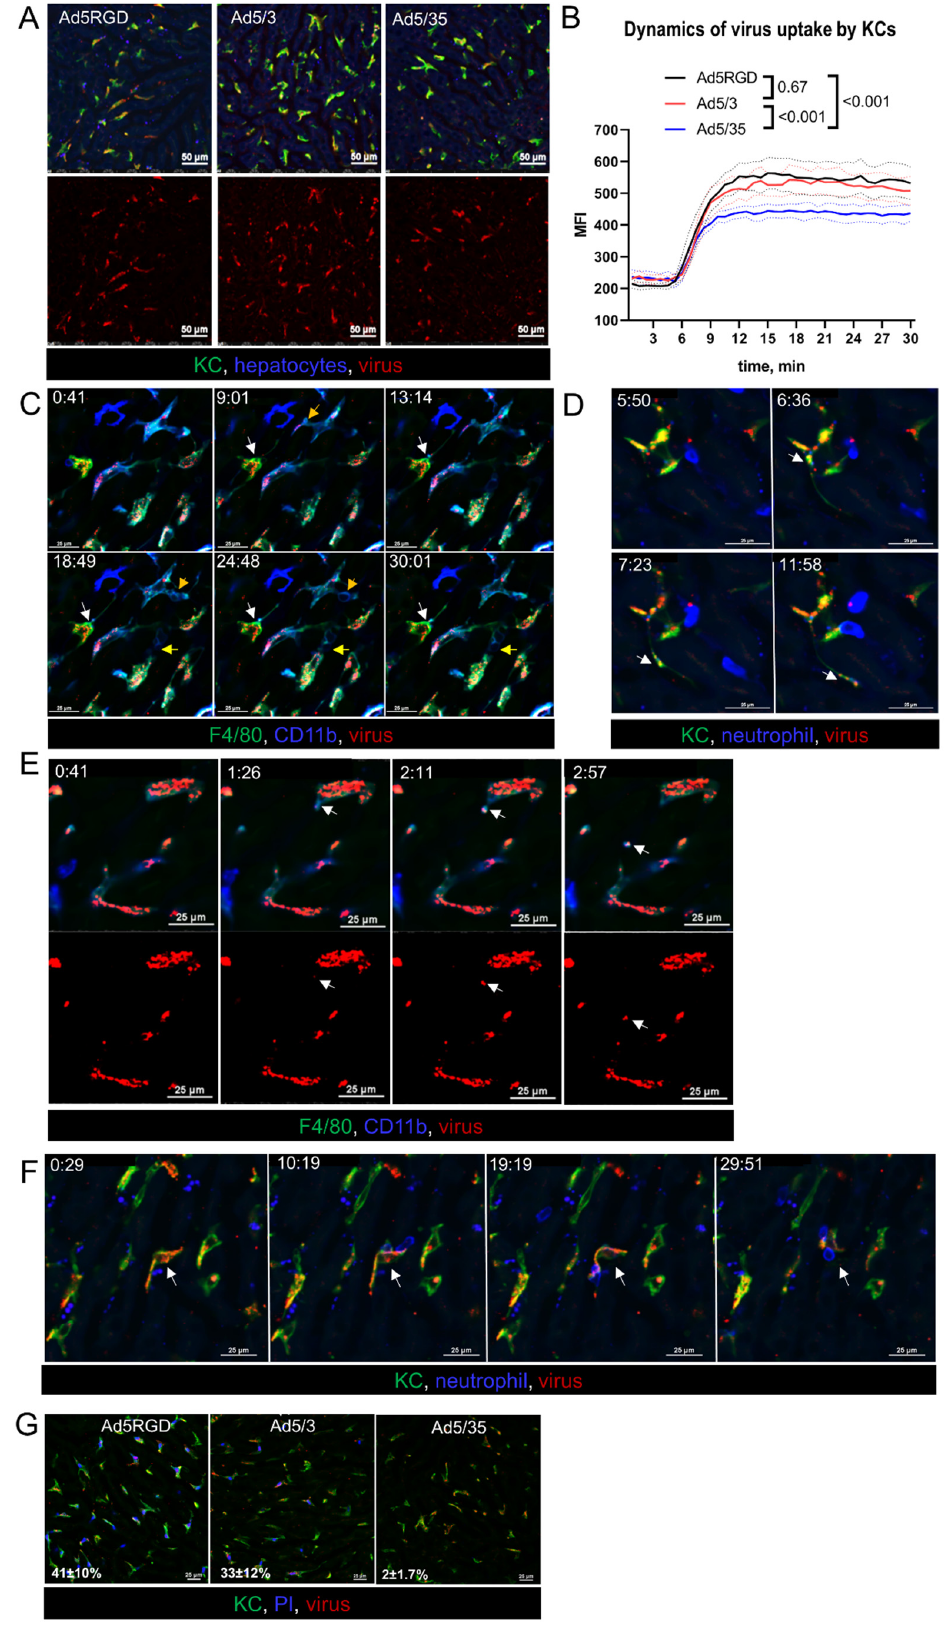
Figure 2. Ad5-RGD and Ad5/3 vectors lead to rapid zeiosis of Kupffer cells. ( A , B ). Representative images ( A ) and quantification ( B ) of adenoviral vectors’ uptake by KCs during 30 min after i.v.